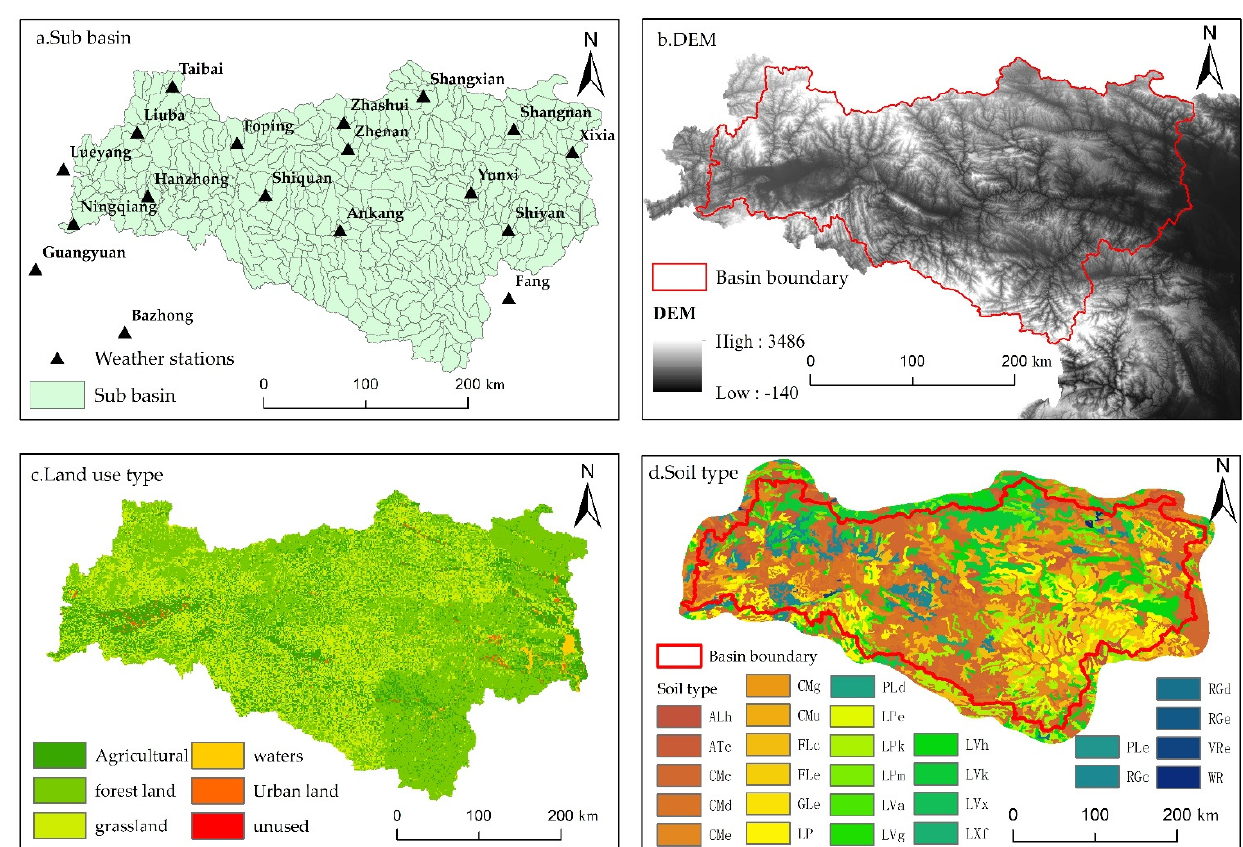
Figure 2. Spatial data required for SWAT model construction in the upper reaches of the Hanjiang River basin.